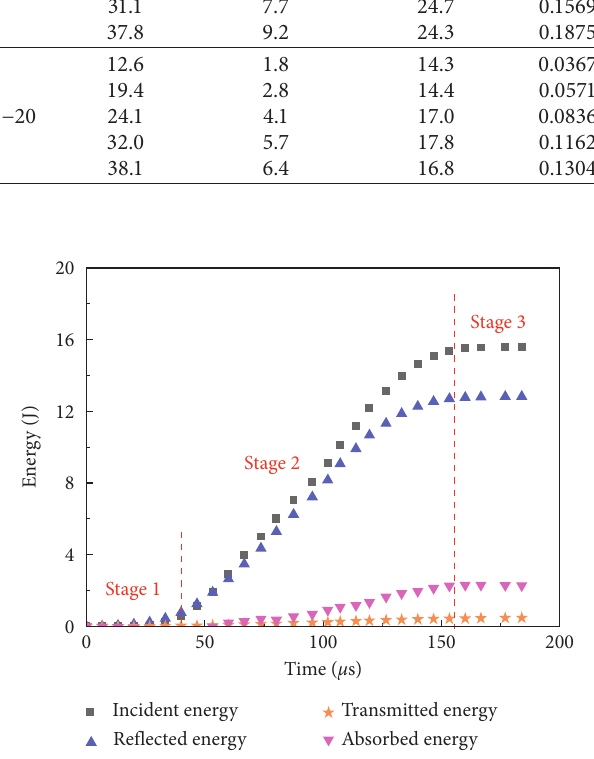
Figure 8: Relationship between dissipated energy and strain